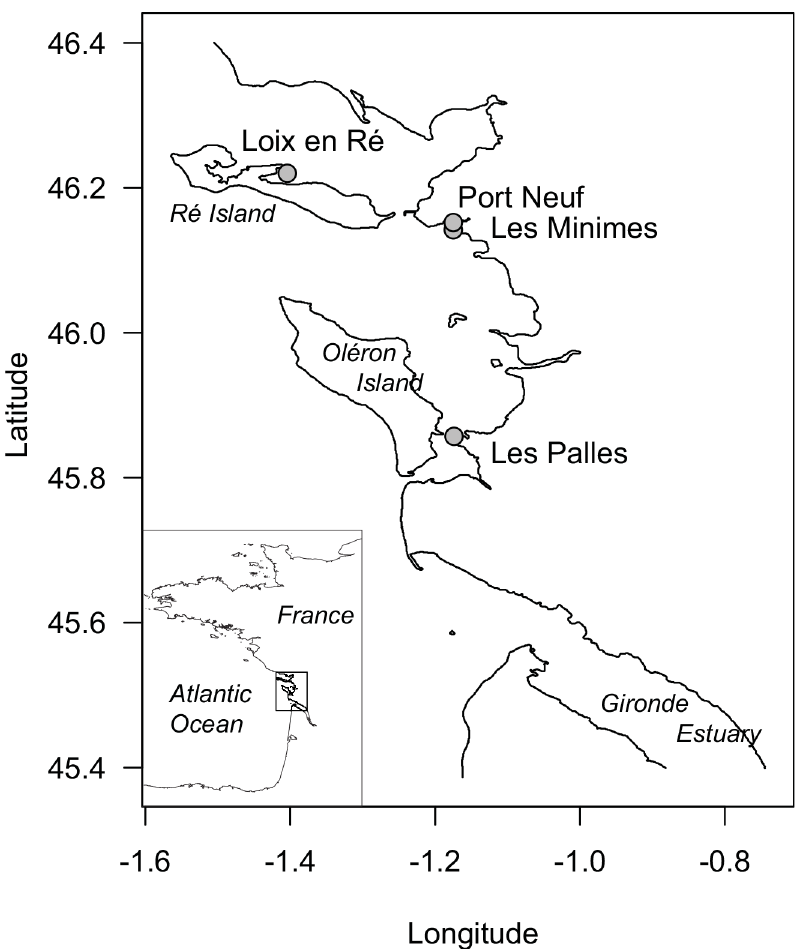
Fig 2. Location of the four sampling areas along the French Atlantic coast: Loix-en-Ré (Ré Island), Les Minimes (near sailing harbour), Port-Neuf (near water treatment of La Rochelle), Les Palles (near the mouth of the Charente